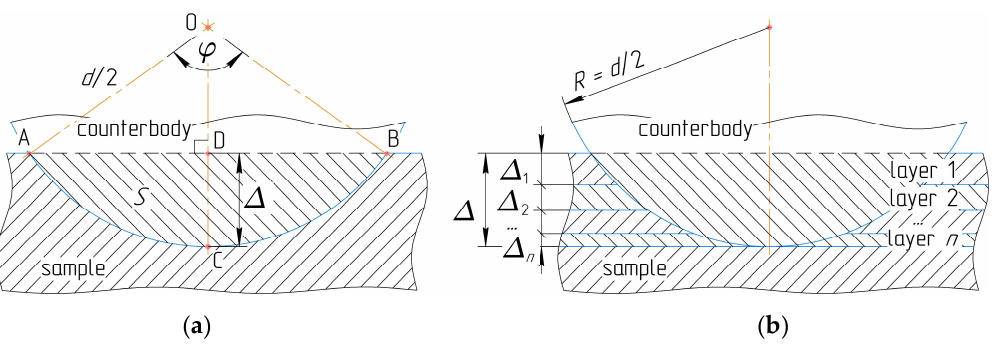
Figure 1. The design scheme for a single layer ( a ) and multilayer ( b ) case studies.